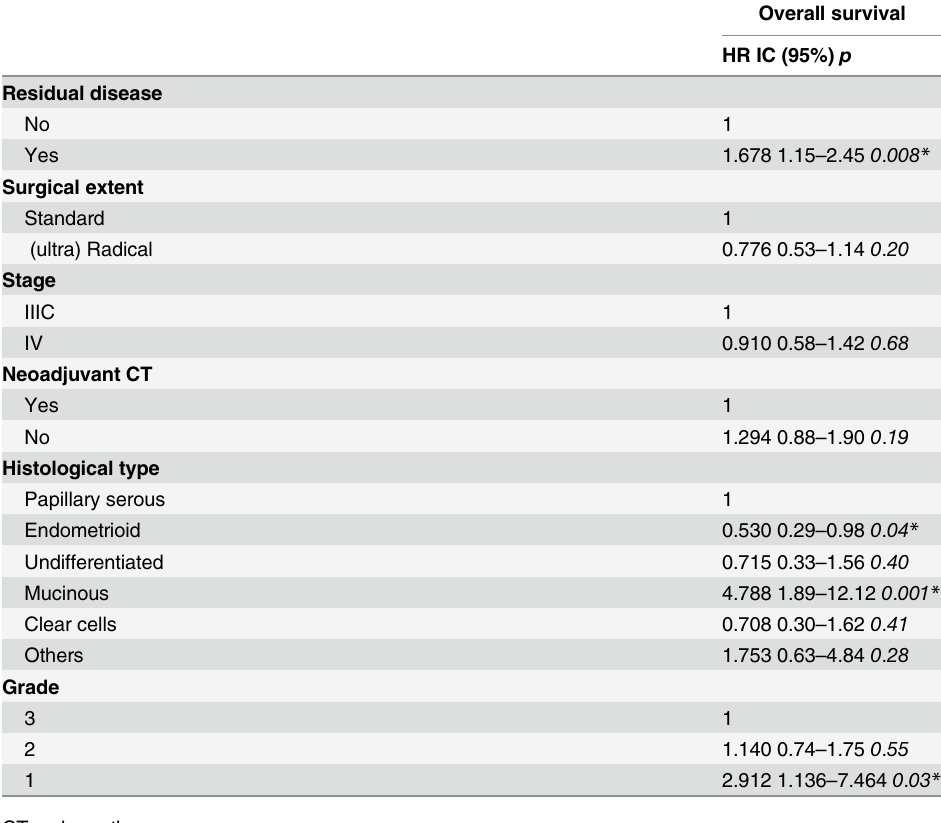
Table 2. Cox logistic regression in Early Relapse group: bivariate